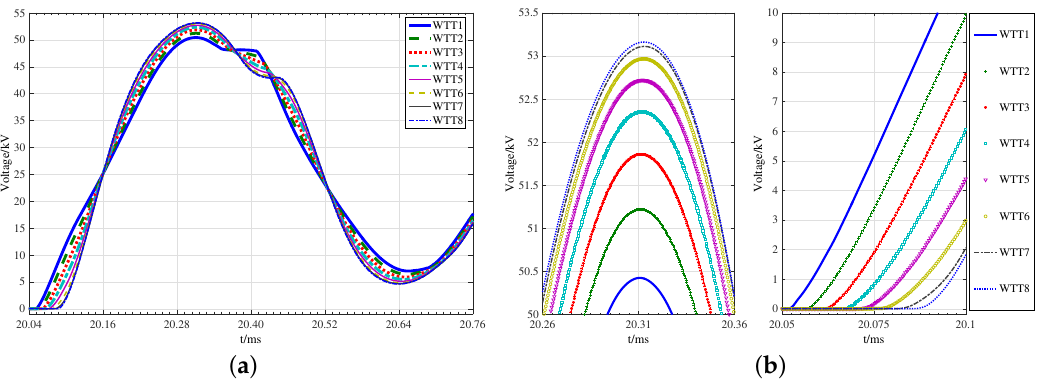
Figure 10. Voltage comparison at different locations on the feeder: ( a ) WTT1 to WTT8 voltage comparison; and ( b ) magnified